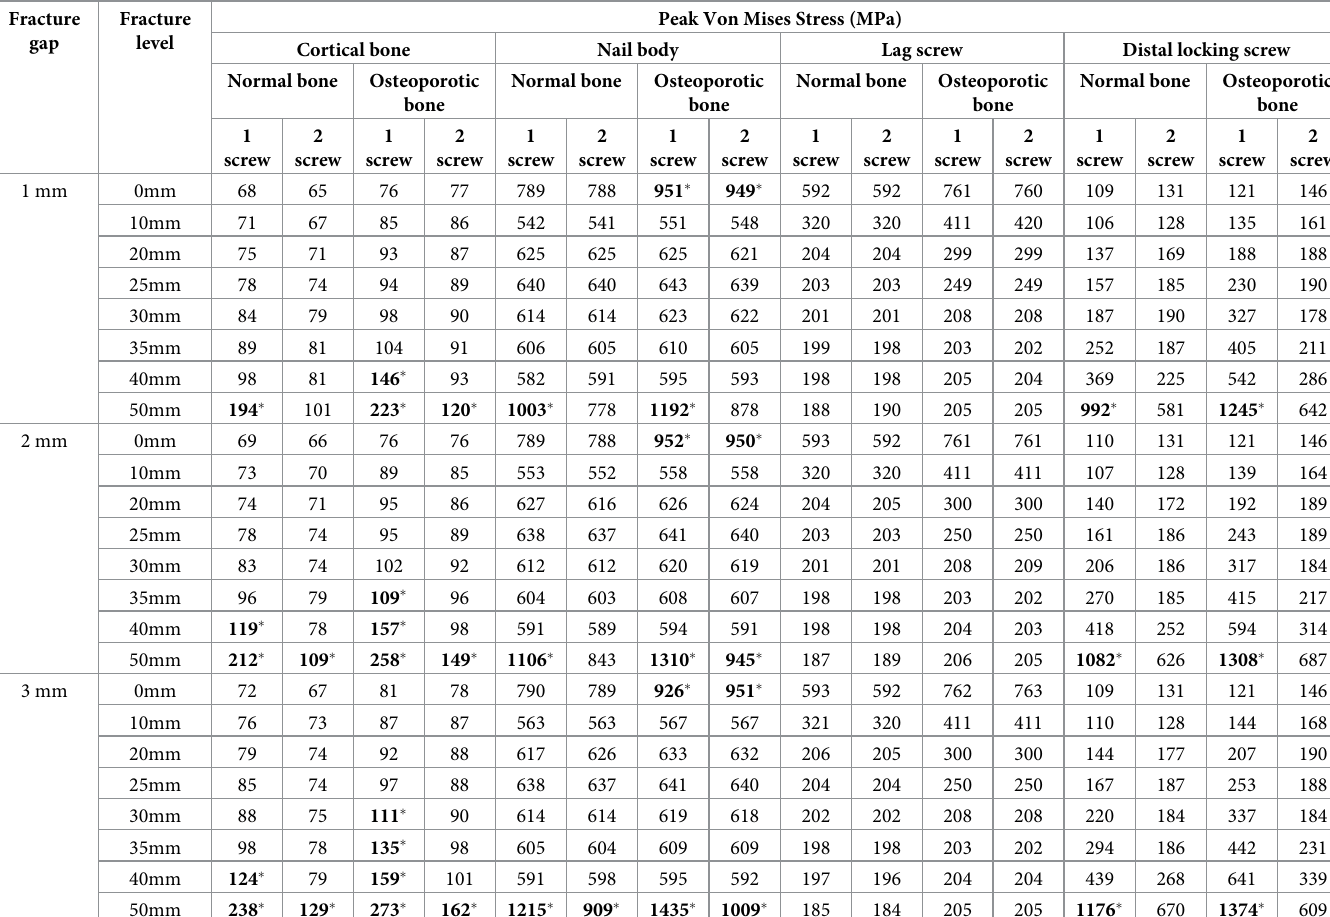
Table 2. Summary of Peak von Mises stress in finite element models according to fracture gap. Fracture Fracture gap